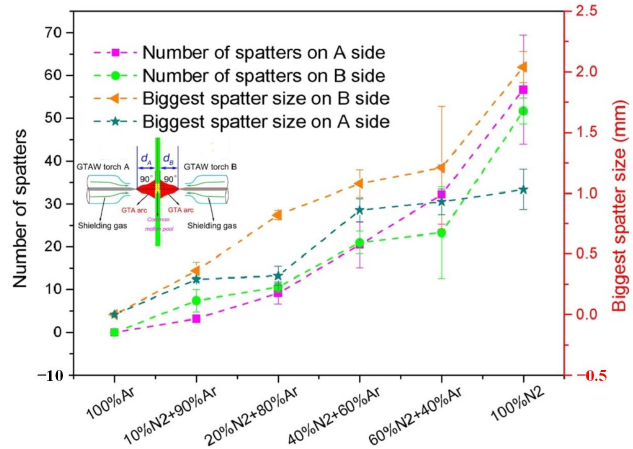
Figure 2. Influence of different contents of N 2 in the shielding gas on spatters in welding. Reproduced with permission from ref. [12]. Copyright 2017, Elsevier.